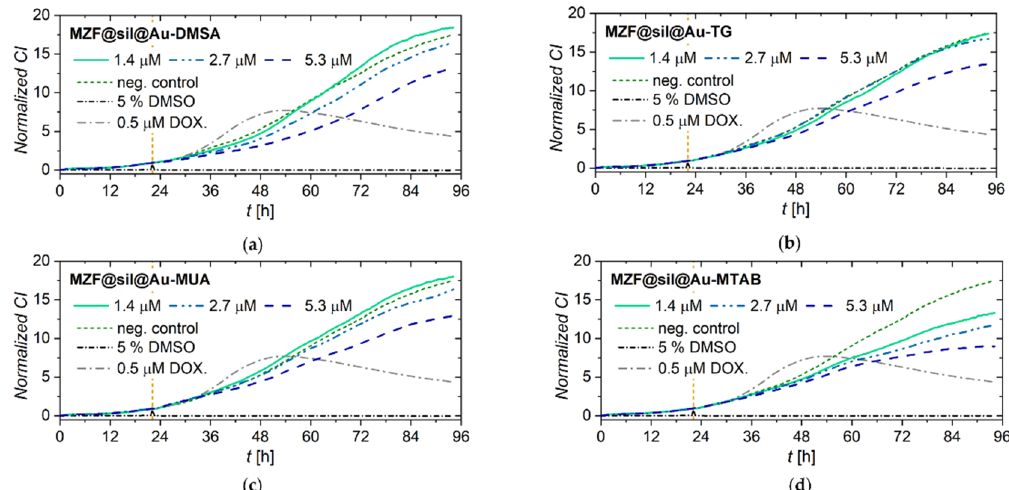
Figure 6. Growth kinetics of human MZF-7 breast carcinoma cells incubated with functionalized gold nanoshells as monitored by the xCELLigence system: Cells treated with ( a ) MZF@sil@Au-DMSA; ( b ) MZF@sil@Au-TG; ( c ) MZF@sil@Au-MUA; ( d ) MZF@sil@Au-MTAB of given concentrations. The negative (vehicle) control was treated with sterile deionized water, whereas the cells treated with 5% DMSO and 0.5 μ M doxorubicin were used as positive controls. The yellow vertical line marks the time point of the treatment.